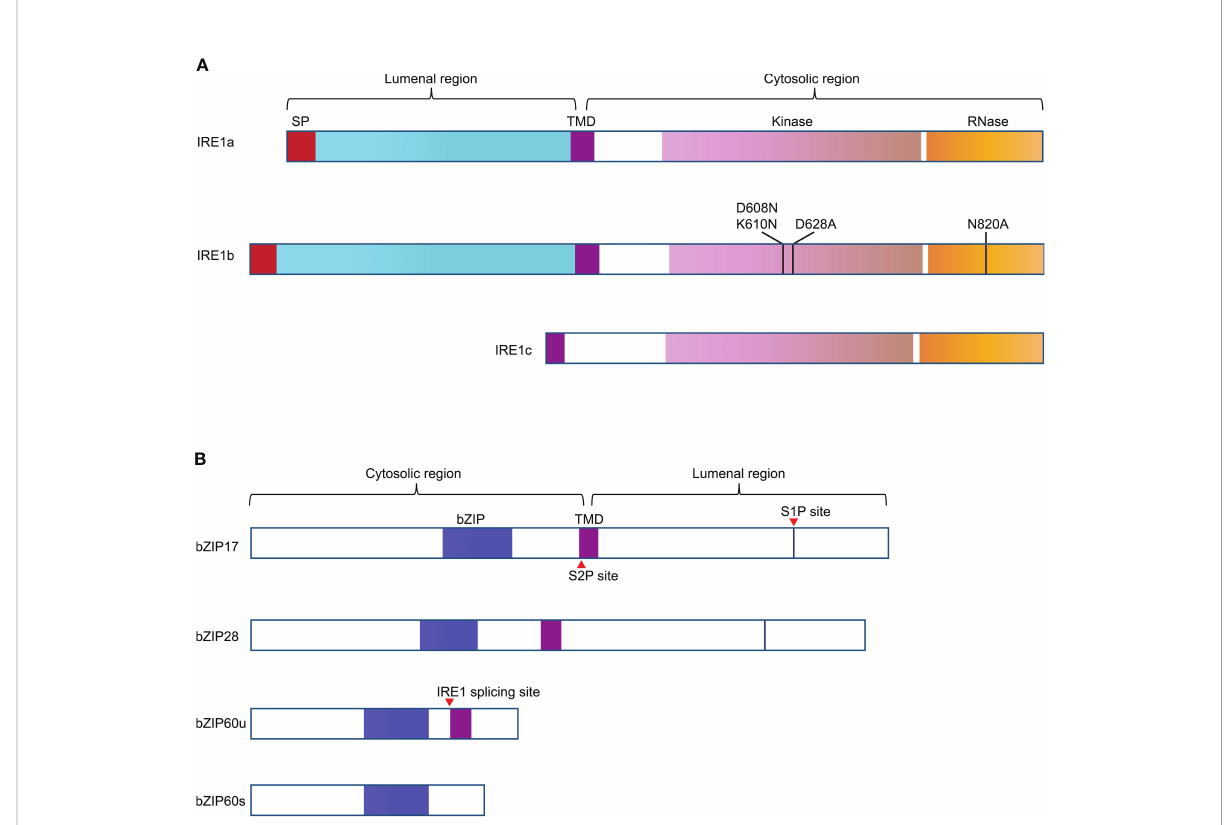
FIGURE 1 Schematic representation of the structural features of the UPR signal transducers in Arabidopsis. (A) A transmembrane domain (TMD) divides IRE1a and IRE1b into two segments. The N-terminal region of IRE1 has a signal peptide (SP, in red) and a sensing domain, facing the ER lumen. The C-terminal region of IRE1 contains the protein kinase domain (in light purple) and RNase domain (in orange), facing the cytosol. The mutation D608N K610N in IRE1b was supposed to be able to block its nucleotide binding activity, D628A mutation in IRE1b can interfere with the protein kinase activity of IRE1b, and N820A mutation knocks out the RNase activity of IRE1b. IRE1c is plant unique as it only has the corresponding TMD and cytosolic region. (B) bZIP transcriptional factors of UPR pathway have N-term cytosolic bZIP domain and C-term luminal region. The blue boxes represent bZIP domains, the purple boxes indicate the TMD, the red triangle arrows represent the corresponding cleavage or splicing site. bZIP60s (active form) and bZIP60u are spliced and unspliced forms of